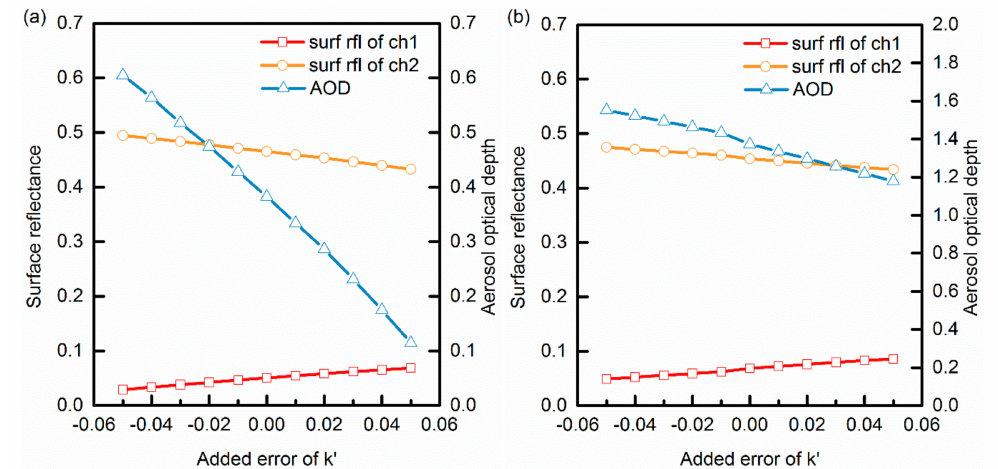
Figure 11. The retrieved AOD values and surface reflectance values with added errors of k (cid:48) when the AOD value is 0.4 ( a ) and 1.5 ( b ), respectively. The solar zenith angle is 22.14 ◦ , satellite zenith angle 48 ◦ , and relative azimuth angle − 156.41 ◦ .